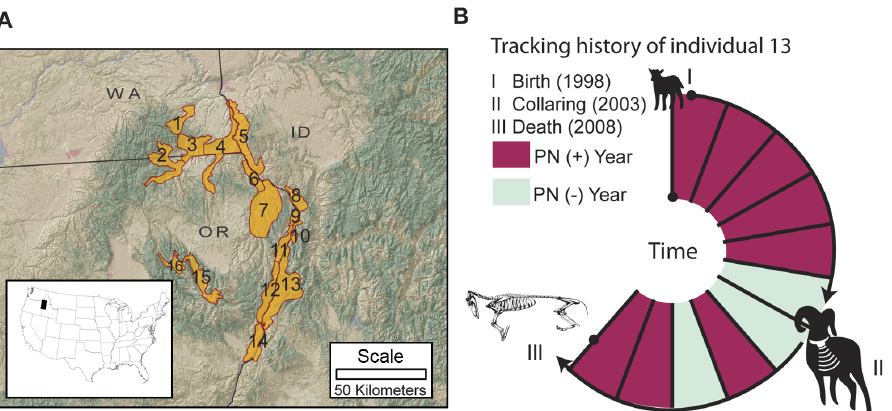
Figure 2. Study area and pneumonia history calculation. A. Study area: we report data from 388 radio-collared adult bighorn sheep and 753 ewe-lamb pairs within 12 of these 16 populations in Hells Canyon (WA=Washington, ID=Idaho, OR=Oregon; see Fig. S1 for populations’ names and pneumonia histories). B. How individual pneumonia histories were constructed. The bighorn sheep in panel B was collared (II) at age 6 and died (III) at age 11 (in the middle of the biological year). Age was estimated at capture (II) or by incisor cementum analysis after death (III). Based on its population’s pneumonia history (red indicates years with pneumonia mortality, green indicates years when pneumonia was not detected; see Fig. S1), this animal experienced 8 pneumonia exposures ( Count =8). The time since last exposure ( Lag ) was 0 when it died.